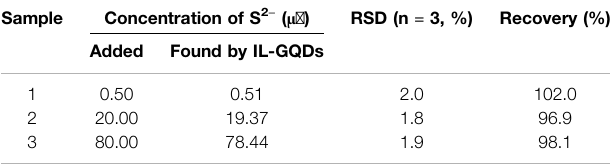
TABLE 1 | Detection of S 2 − in river water